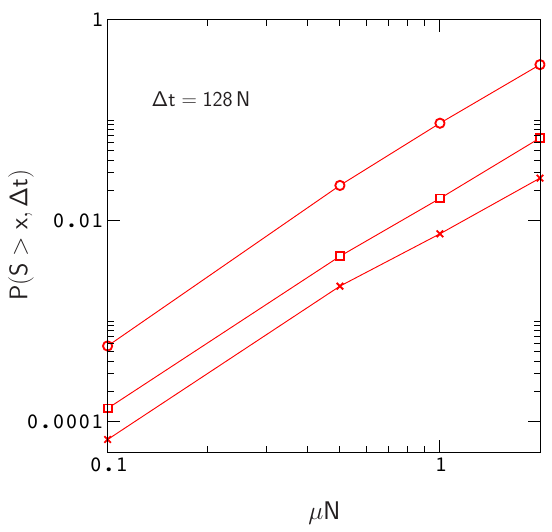
Figure 4. P ( S > x , ∆ t ) versus µ N for x (cid:39) 9.1 (circles), 17.8 (squares) and 27.8 (crosses). The results